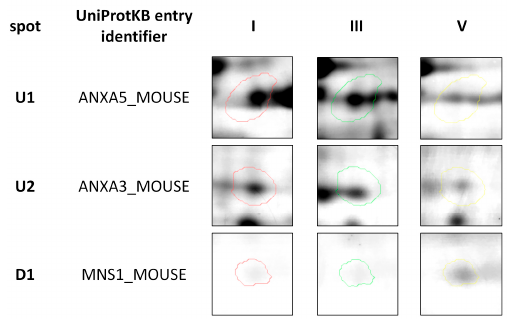
Figure 2. Representative two-dimensional electrophoresis gels of significantly ( p ≤ 0.05) differentially expressed proteins in feline fibrosarcomas from both the FFS1 cell line versus the FFS5 cell line, and the FFS3 cell line versus the FFS5 cell line.